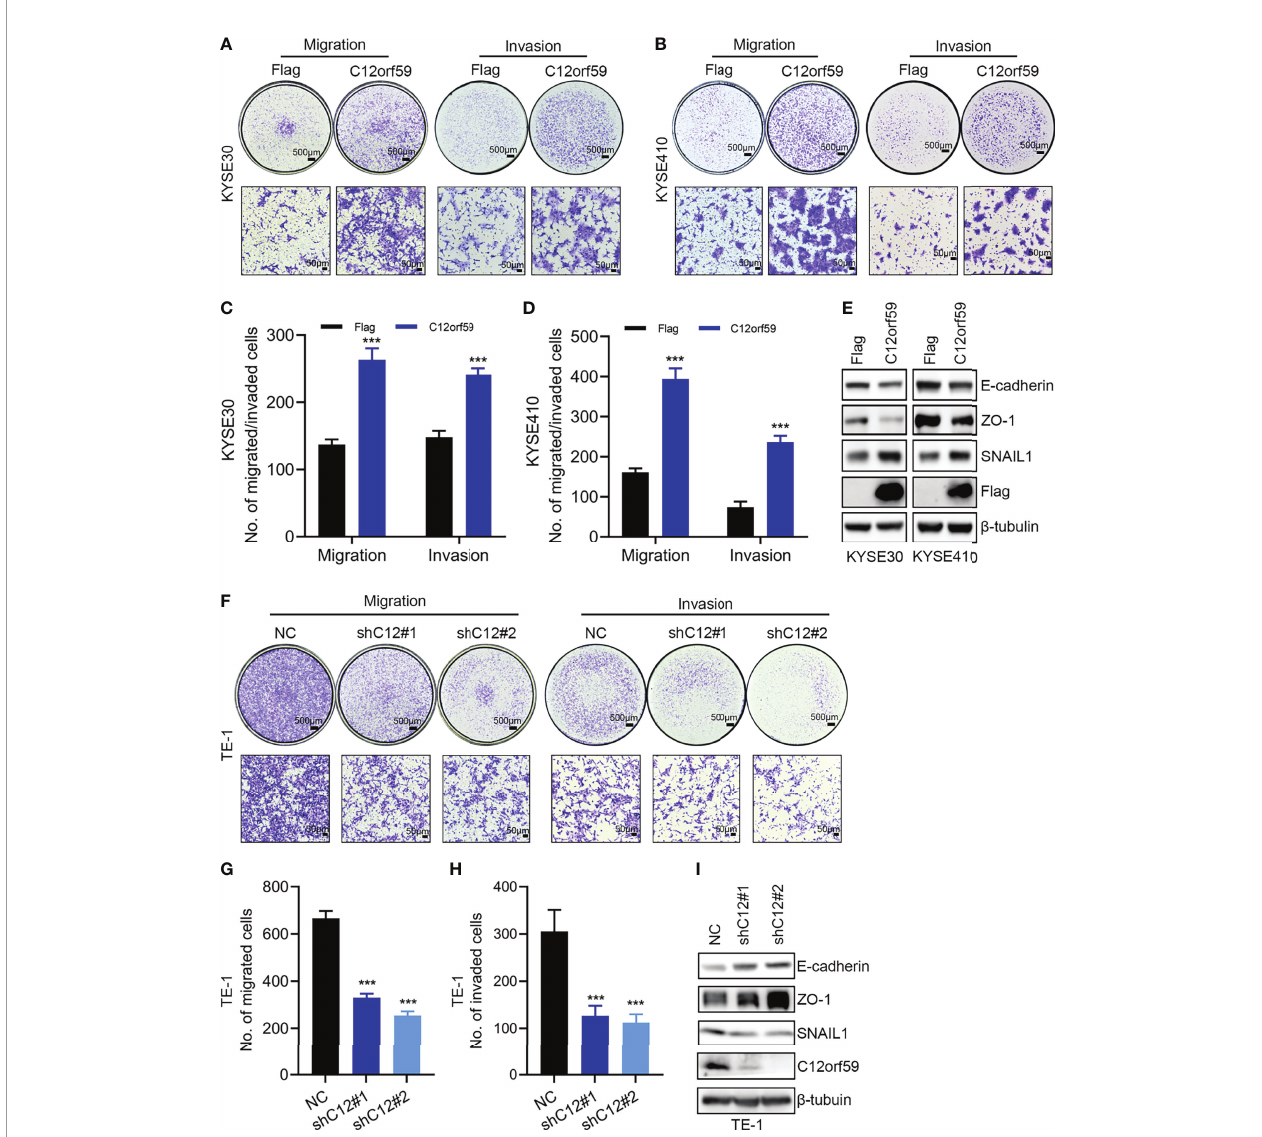
FIGURE 3 | C12orf59 promotes EMT and cellular motility of ESCC cells. (A, B) Transwell assays were used to investigate the capabilities of migration and invasion of KYSE30 and KYSE410 cells infected with control or C12orf59-expressing lentivirus. Scale bar, 500 m m for low and 50 m m for high magni fi cation. (C, D) Quantitative data of migrated or invaded KYSE30 and KYSE410 cells were shown. (E) Protein levels of EMT markers (E-cadherin, ZO-1, and SNAIL1) in KYSE30 and KYSE410 cells with or without C12orf59 overexpression were detected by western blotting. (F) Migration and invasion of TE-1 cells infected with control or C12orf59-shRNA-expressing lentivirus were measured by transwell assays. Scale bar, 500 m m for low and 50 m m for high magni fi cation. (G, H) Quantitative data of migrated or invaded TE-1 cells were shown. (I) Protein levels of EMT markers (E-cadherin, ZO-1, and SNAIL1) and C12orf59 were measured by western blotting in TE-1 cells with or without C12orf59 silencing. b -tubulin was used as the loading control for western blotting. Data were presented as mean values with standard deviations, *** p <